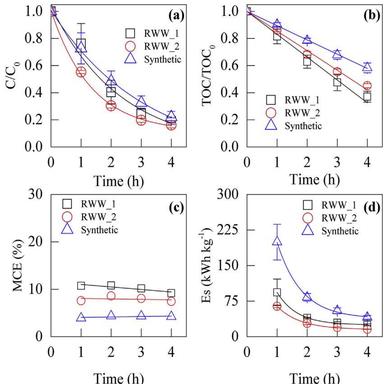
Influence of water matrix and sodium sulfate concentration in the PRED degradation (a), mineralization profile (b), mineralization current efficiency (c) and energy consumption (d) for the real wastewater assays for the EAO without the supporting electrolyte (RWW_1) and with the supporting electrolyte (RWW_2). EAO conditions: 50 mg L1 of PRED, 20 mA cm2 , initial pH 11 at room temperature.